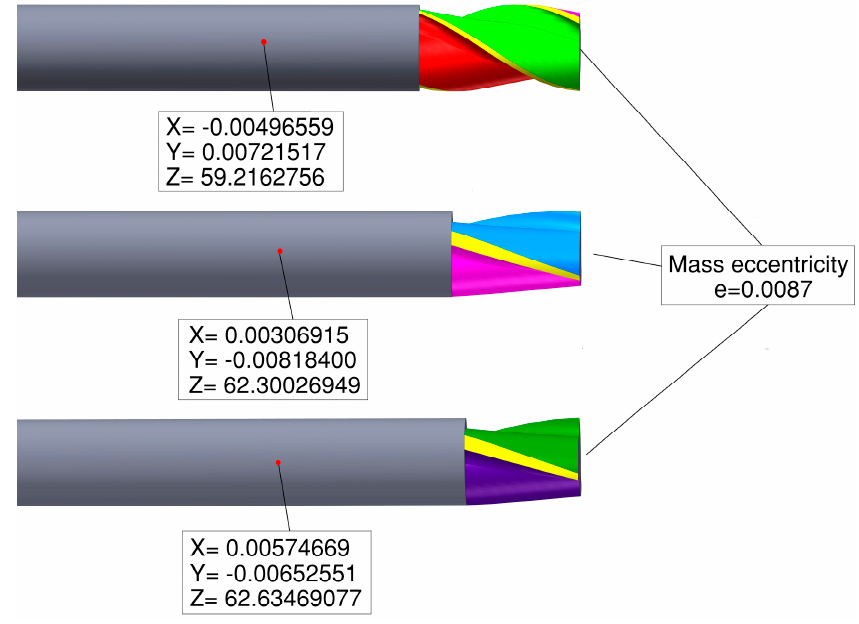
Figure 4. Geometric model of irregular tooth end milling cutter.